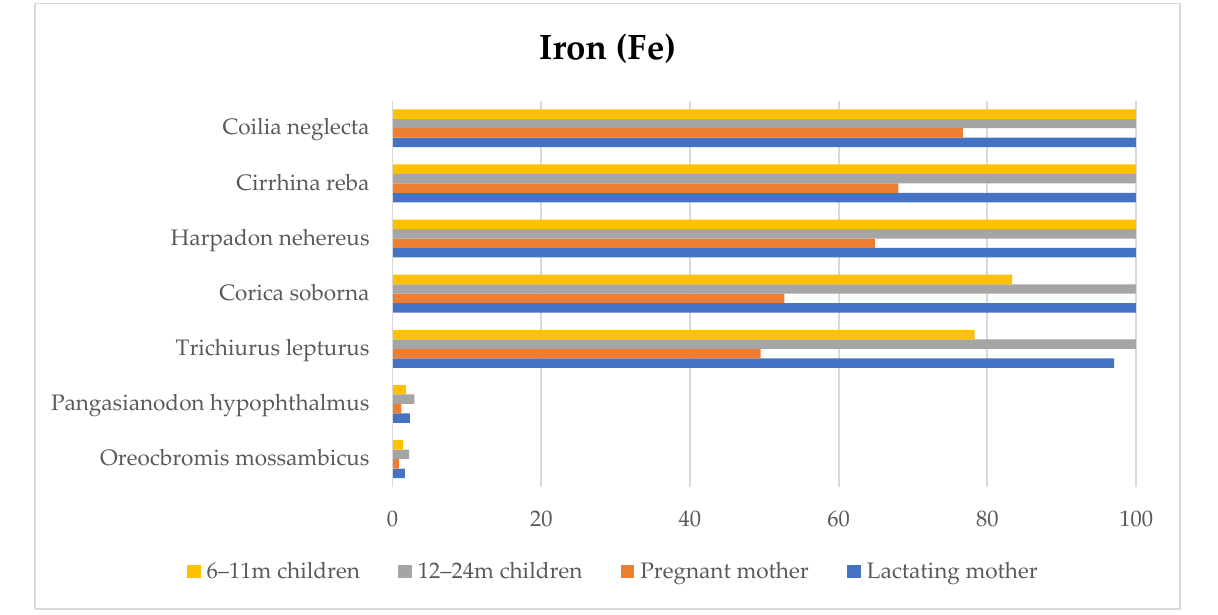
Figure 3. Potential contribution (%) of dry fish to the RNI of iron for children and pregnant and lactating women in Bangladesh. Local names: Olua ( Coilia neglecta ), Bata ( Cirrhina reba ), Loitta ( Harpadon nehereus ), Kachki ( Corica soborna ), Churi ( Trichiurus lepturus ), Thai Pangas ( Pangasianodon hypophthalmus ), and Tilapia ( Oreocbromis mossambicus ). Zinc (Zn) was analyzed in 3.37% ( n = 38) of entries, and we found that the average zinc content of dry fish was 4.31 mg (per 100 g of dry fish). The zinc content ranged from 0.23 mg to 19.30 mg per 100 g, and the highest amount was identified in dried Tengra ( Mystus tengra ). In many low- and middle-income countries including Bangladesh, zinc is deficient in diets. Thus, zinc-rich dry fish can contribute to reducing the gap. As demonstrated in Figure 4, a daily serving of dried Tengra provides 100% of the recommended intake of zinc for children aged up to two years and pregnant and lactating mothers. Like other nutrients , dry fish contributes much more to individuals’ recommended zinc intake compared to reference fresh fish (Figure 4).